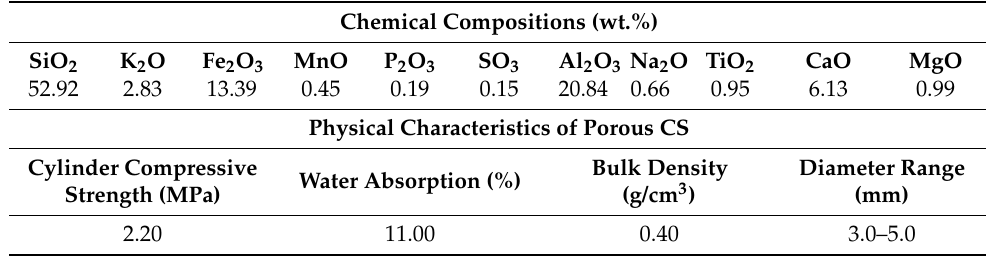
Table 2. Chemical composition and physical characteristics of porous ceramsite (CS).